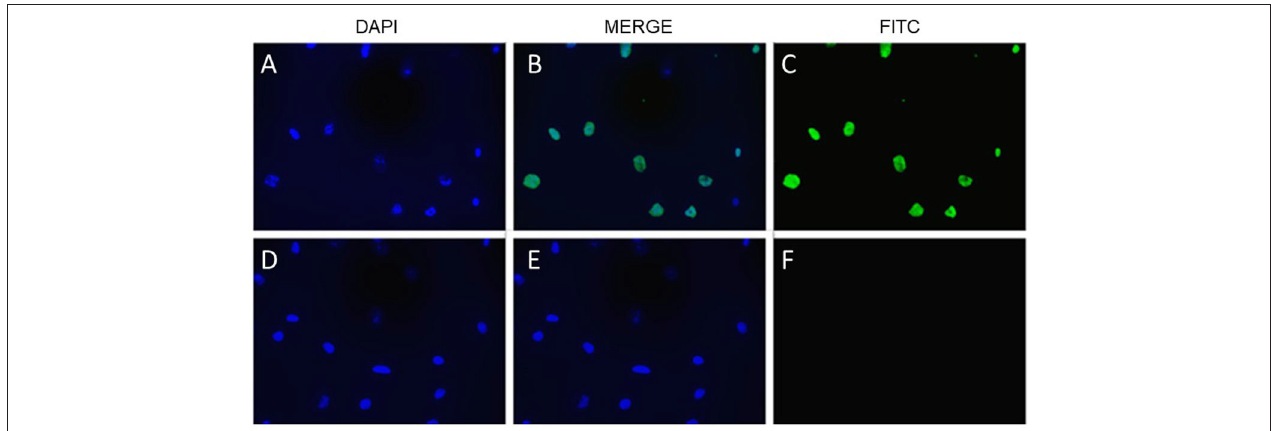
FIGURE 7 | Cytotoxic milk and apoptosis in fetal intestinal cells. TUNEL staining of FHs 74 cells, with DAPI stain of cells exposed to milk 92 days old (A) , FITC stain (C) and merged image (B) . (D–F) are DAPI, merged and FITC stain of cells exposed to milk 40 days old. Bottom row are cells exposed to milk 40 days old. Fluorescent microscopy of cells mounted on glass